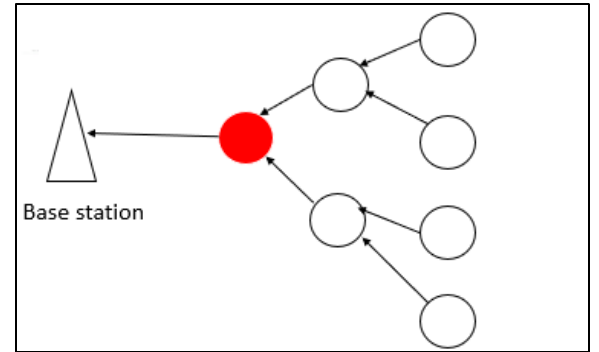
Figure 2. An illustration of the Sinkhole attack